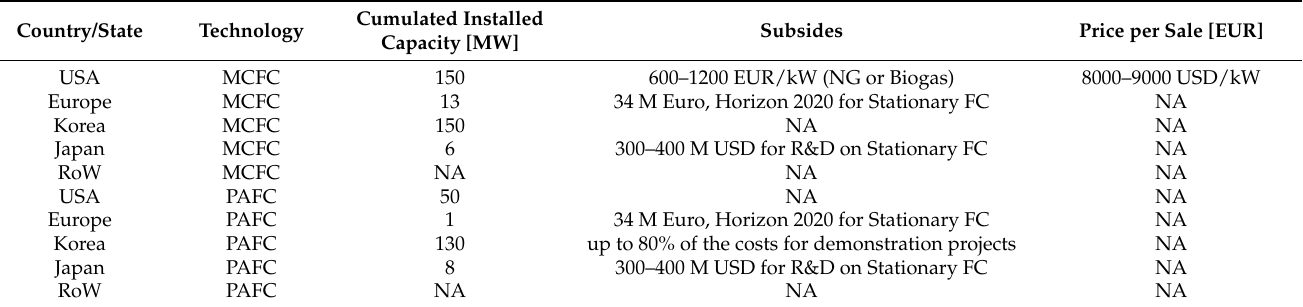
Table 3. MCFC and PAFC, Large-scale Installations.